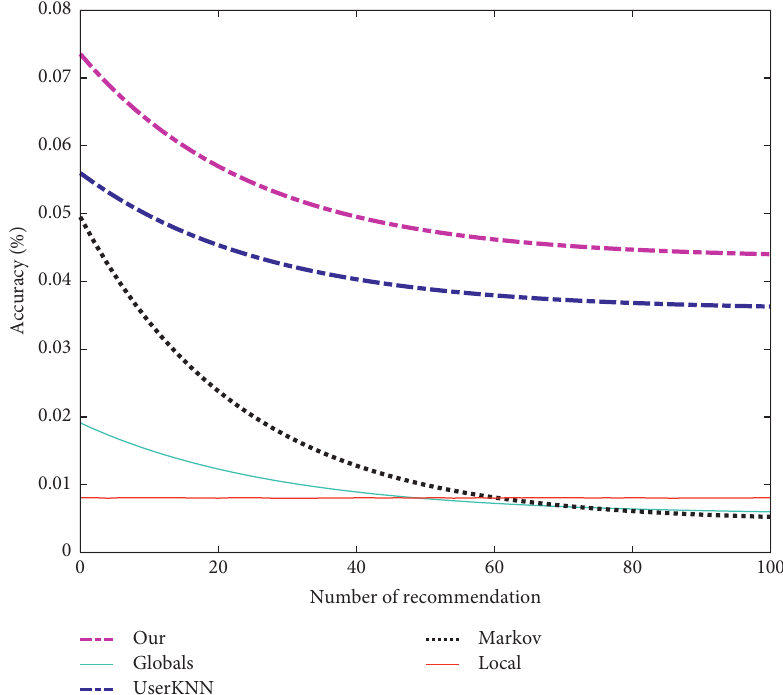
Figure 7: The comparison results compared with the PrefixSpan method.